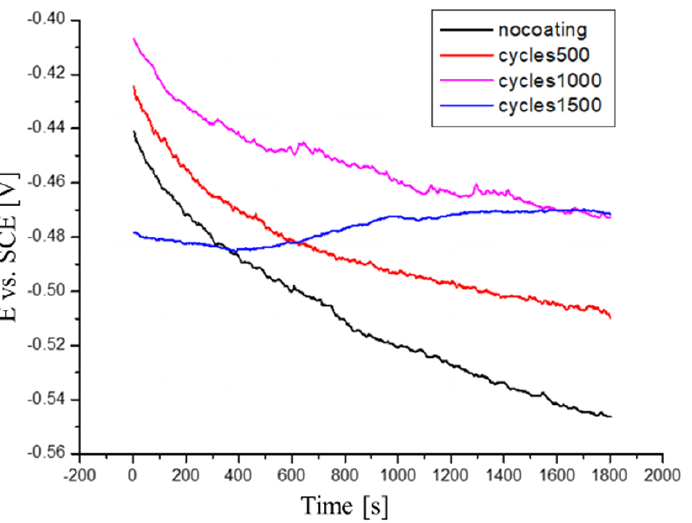
Figure 10. Variation of the open-circuit potential with time in the 3.5% NaCl solution at 25 °C.